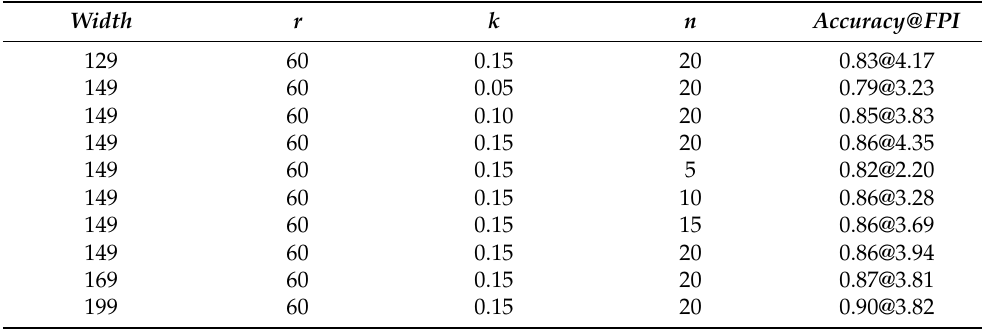
Table 8. Performance of the proposed GFNet framework on CBIS-DDSM parameters with KNN 20 as the classifier of false positive reduction and without NMS.